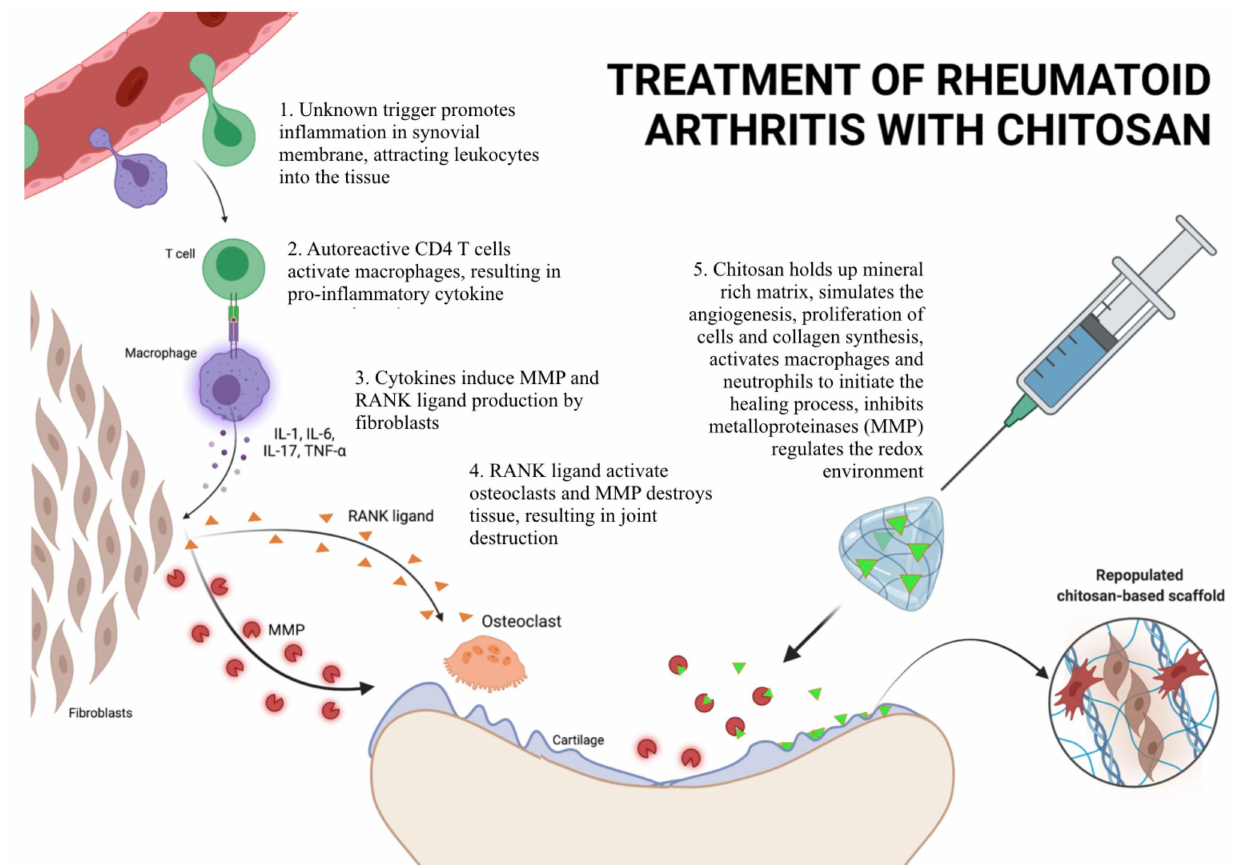
Figure 5. Treatment of rheumatoid arthritis with chitosan based on the literature [83]. IL-1: interleukin 1; IL-6: interleukin 6; IL-17: interleukin 17; MMP: matrix metalloproteinases; RANK ligand: Receptor Activator for Nuclear Factor κ B Ligand; T cell: lymphocyte type T; TNF α : tumor necrosis factor α . Figure 5 was created with BioRender.com. (accessed on 17 December